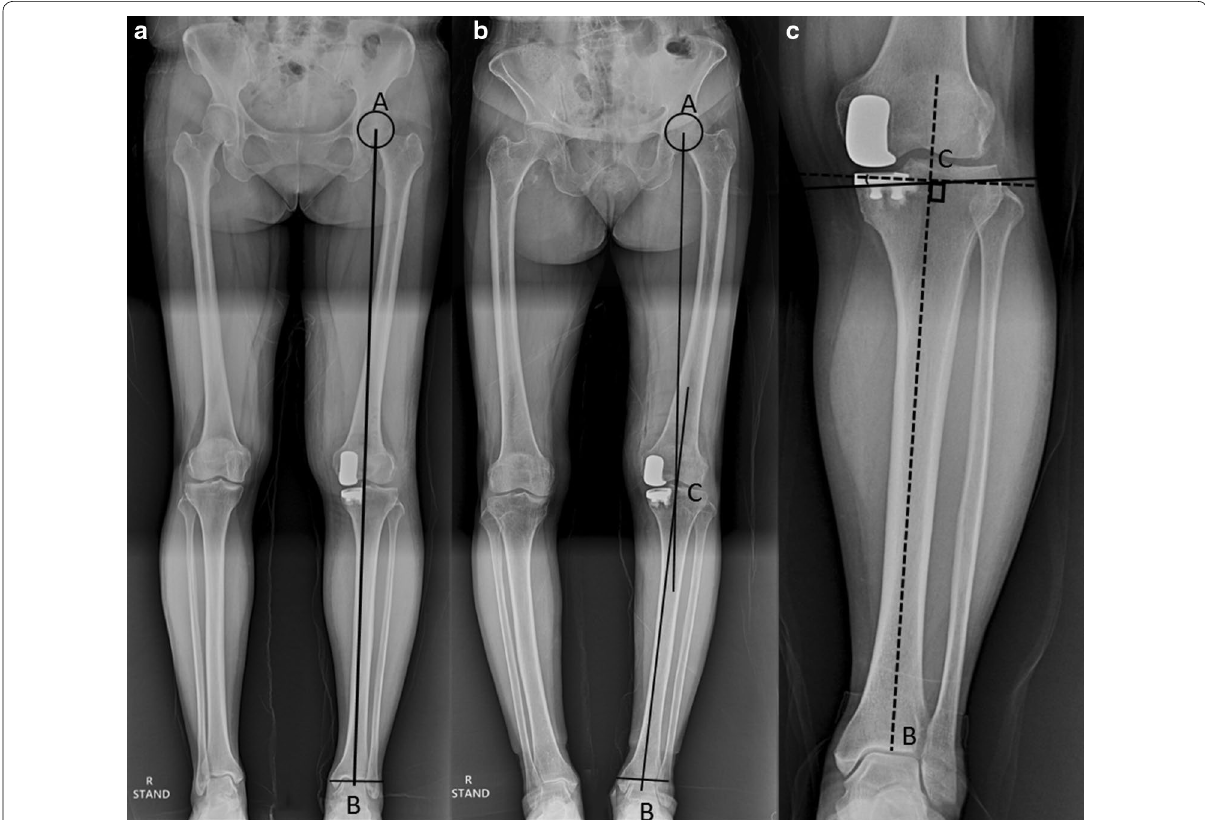
Fig. 3 a Mechanical axis (Maquet’s line) is a line from center of femoral head (A) to center of ankle (B); b Hip-knee-ankle axis is the angle between mechanical axis of femur (A to center of knee, C) and mechanical axis of tibia (C to B); c Tibial component coronal alignment is the angle between the line perpendicular to the mechanical axis of tibia and coronal axis of tibial